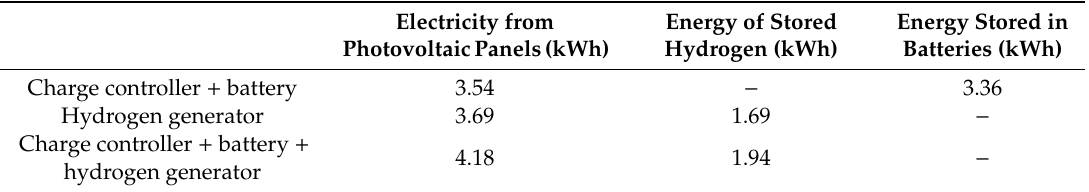
Table 3. Energy received and stored in analyzed systems during one specific day referenced to a 1 kW photovoltaic